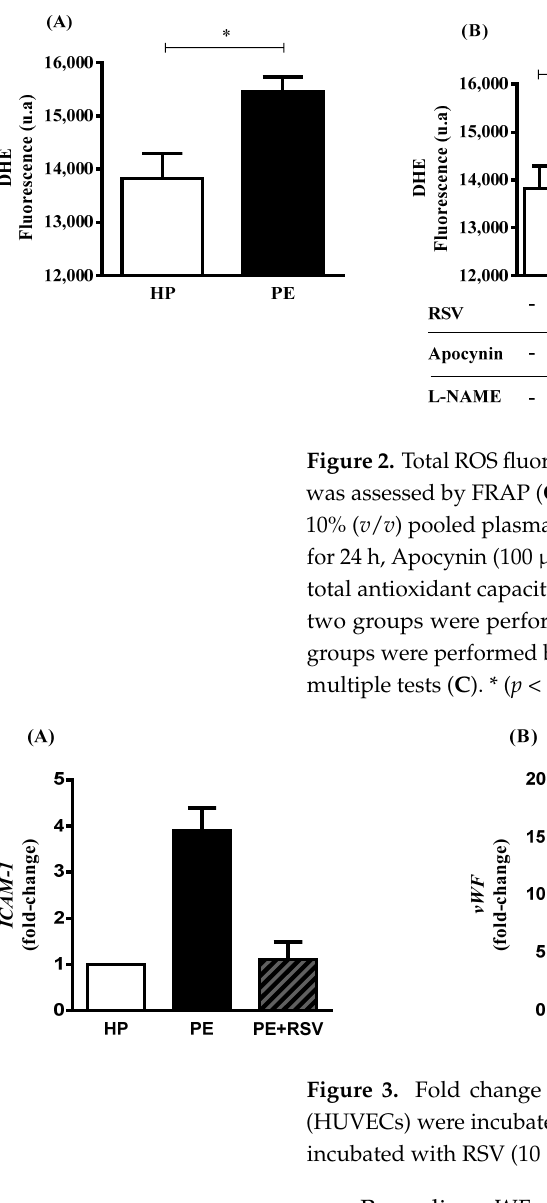
Table 2. Clinical parameters of the umbilical arteries from each PE patients.